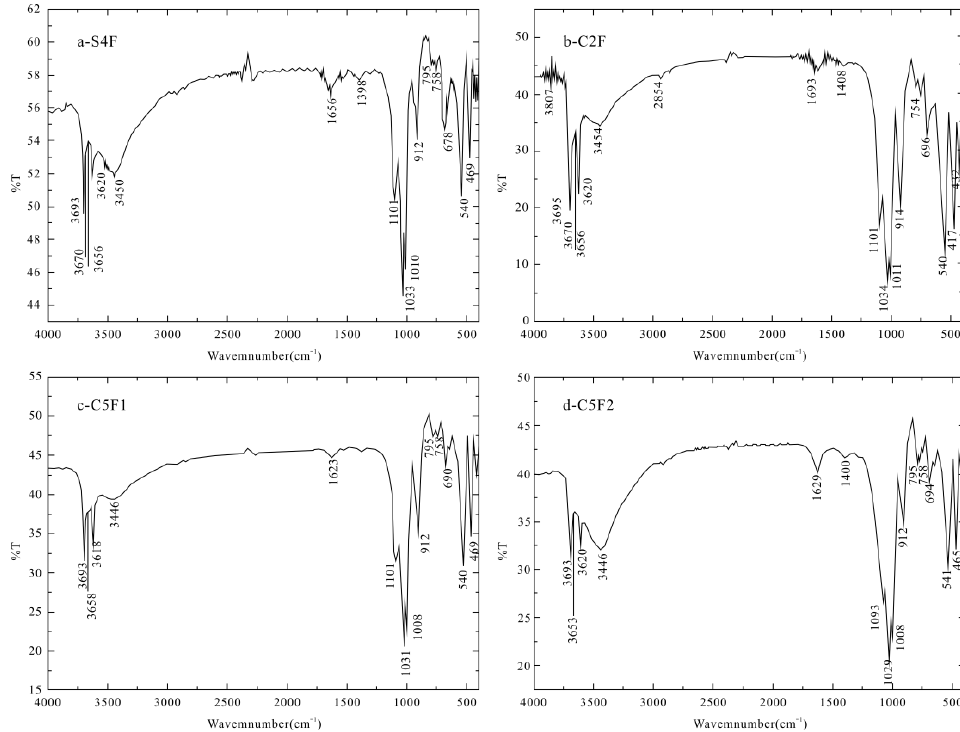
Figure 7. The IR spectra of some kaolinite rock: ( a – d ) represent samples S4F, C2F, C5F1 and C5F2, respectively.